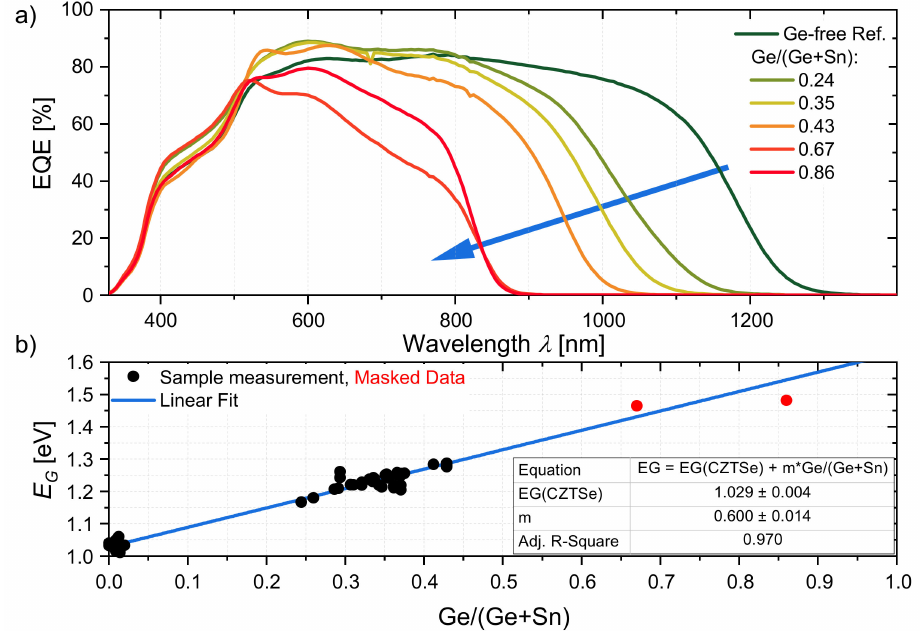
Figure 2. ( a ) EQE spectra for selected samples and ( b ) extracted band gaps over Ge/(Ge + Sn) ratio determined from EDX measurements. The estimated uncertainty in values is ± 0.01 for Ge/(Ge + Sn) ratio for samples up to Ge/(Ge + Sn) = 0.43 and ± 0.04 for the masked data (excluded samples with Ge/(Ge + Sn) ≥ 0.67). The band gap values have an uncertainty around 1 meV, estimated based on the fitting